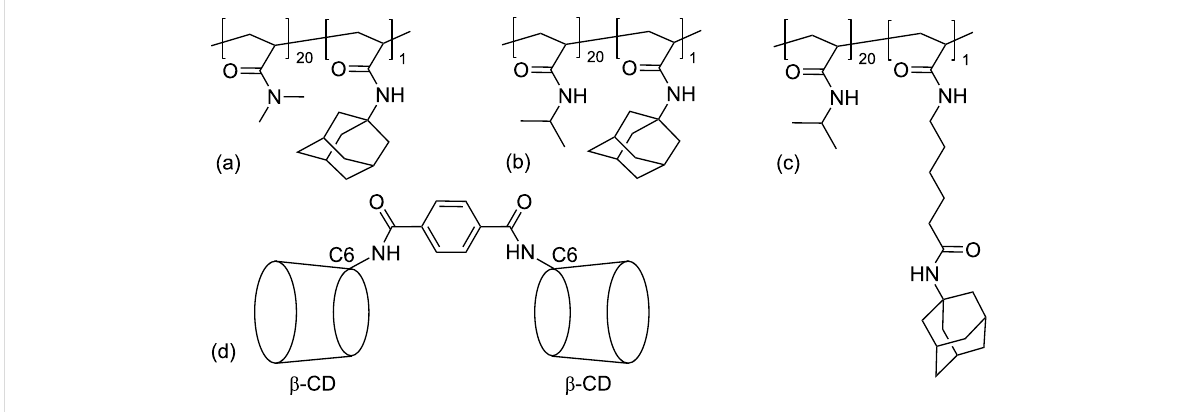
Figure 18: Copolymers of either (a) N , N -dimethylacrylamide (DMAA) or (b) N -isopropylacrylamine (NIPAAM) with 1-adamantylacrylamide, and (c) copolymer of NIPAAM with 6-acryloylaminohexanoic acid [102]. (d) The β -CD dimer in which substitution is at the C6 carbon of a D-glucopyra- nose subunit of each β